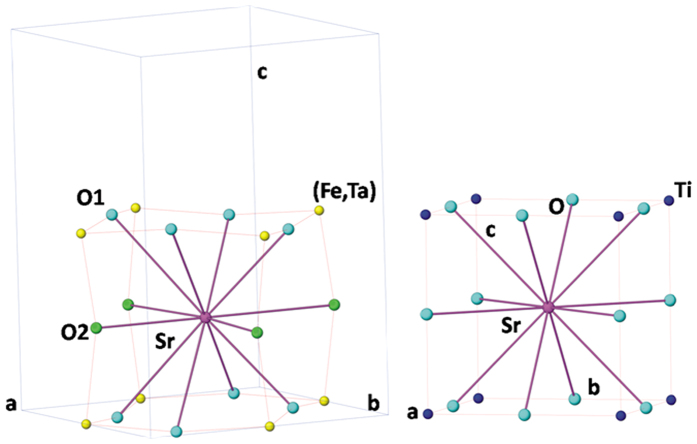
Representations for structures of orthorhombic (SrFe0.5Ta0.5O3) (left) and cubic (SrTiO3) (right).